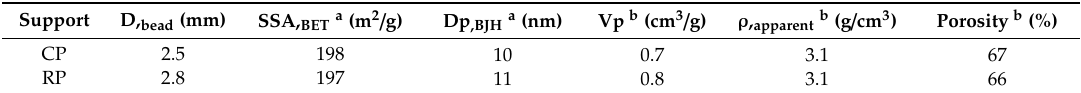
Table 2. Textural analysis of the catalyst supports, where a means assessed by nitrogen sorption and b by mercury intrusion porosimetry.